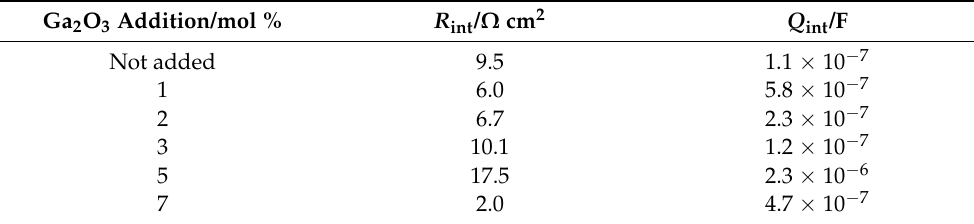
Table 3. R int and Q int are obtained by equivalent circuit fitting electrochemical impedance of sym- metric cells composed of Ta-doped LLZO with or without Ga 2 O 3 addition.